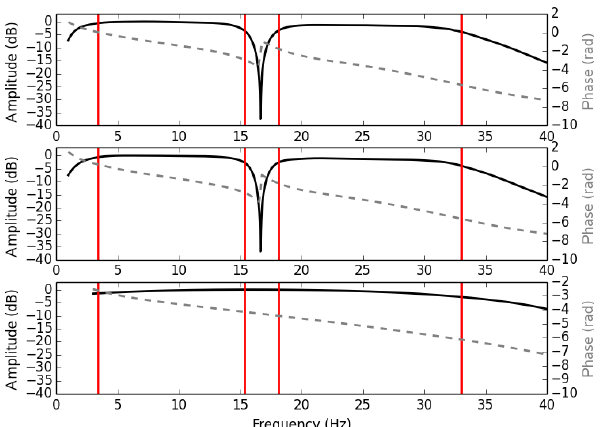
Figure 10. Amplitude and phase response functions of the SR recording system in the observatory. Vertical lines mark the fre- quency bands within which the original signal amplitudes can be reconstructed. Notch filters at 16.66 ( = 50 / 3)Hz are applied in the magnetic data channels to suppress the characteristic narrowband noise from Austrian railway lines which has very high